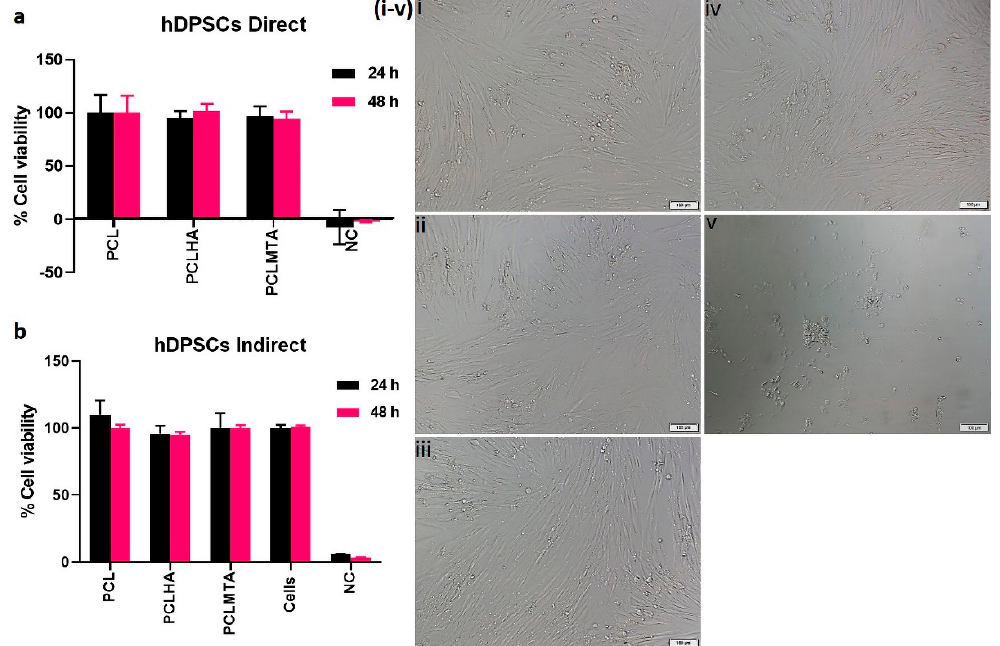
Figure 7. Cell viability analysis of hDPSCs on the electrospun PCL membranes by direct ( a ) and indirect ( b ) XTT method after an incubation period of 48 h. The phase contrast microscopic images of the hDPSCs after 48 h treatment with different PCL-membrane extracts is shown in ( i – v ); PCL ( i ), PCLHA ( ii ), and PCLMTA ( iii ). The hDPSCs displayed the same characteristic spindle-shaped morphology as that of the cells in normal cell culture media ( iv ). However, the negative control cells (NC) in DMSO showed rounded morphology ( v ). The scale bar in the figure represents 100 µ m.